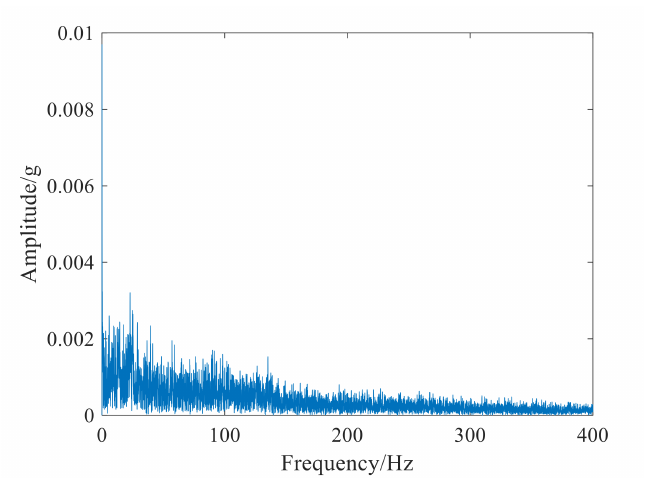
Figure 15. The envelope spectrum analysis results.